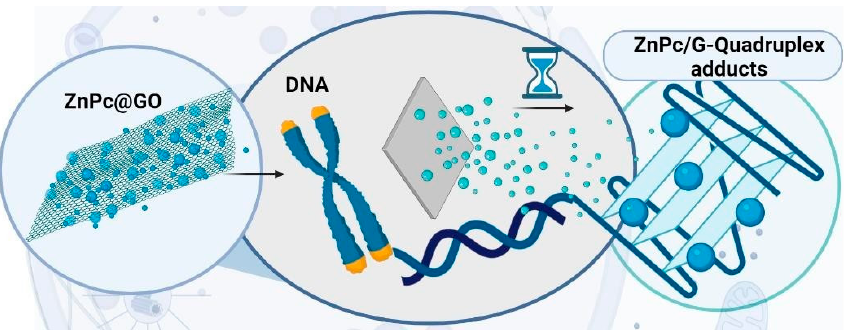
Figure 12. Stabilization of G-Q by the release of ZnPcs from GO nanosheets. Figure 1. Stabilization of G-Q by the release of ZnPcs from GO